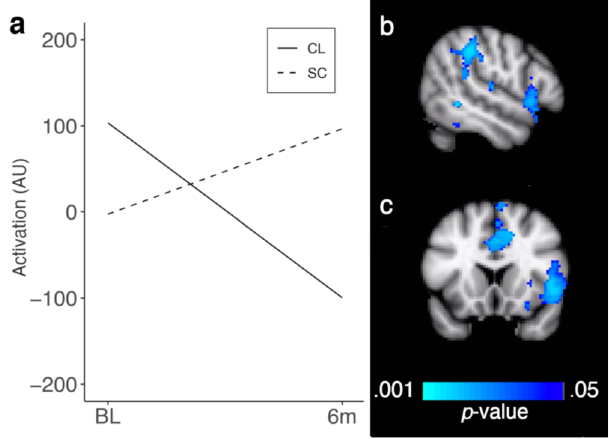
Fig. 4 | Longitudinal differences in brain activation between groups. Results from fMRI analyses showing a greater reduction in activation over time in the Closed Loop (CL) relative to the Standard Care (SC) group. a Line chart showing changes in regional activity over time by group based on mixed-effects modeling conditionalonage(Yaxisis inarbitraryunitsor “ AU ” ).The rightpanel( b , c )shows brain areas that exhibited a signi fi cant interaction of group by time in voxel-wise linearmixedeffectscontrollingforage.Signi fi cancemapswerethresholdedusinga two-tailed alpha of 0.05, corrected for multiple comparisons. Cool colors indicate reduced activation over time in the CL relative to the SC group. Group by time differences were predominantly located in subregions of the executive function network,includingtherightinferiorfrontalgyrusandrightparietalcortexaswellas the dorsal anterior cingulate cortex. Panel b displays a sagittal view of the brain; panel c displays a coronal